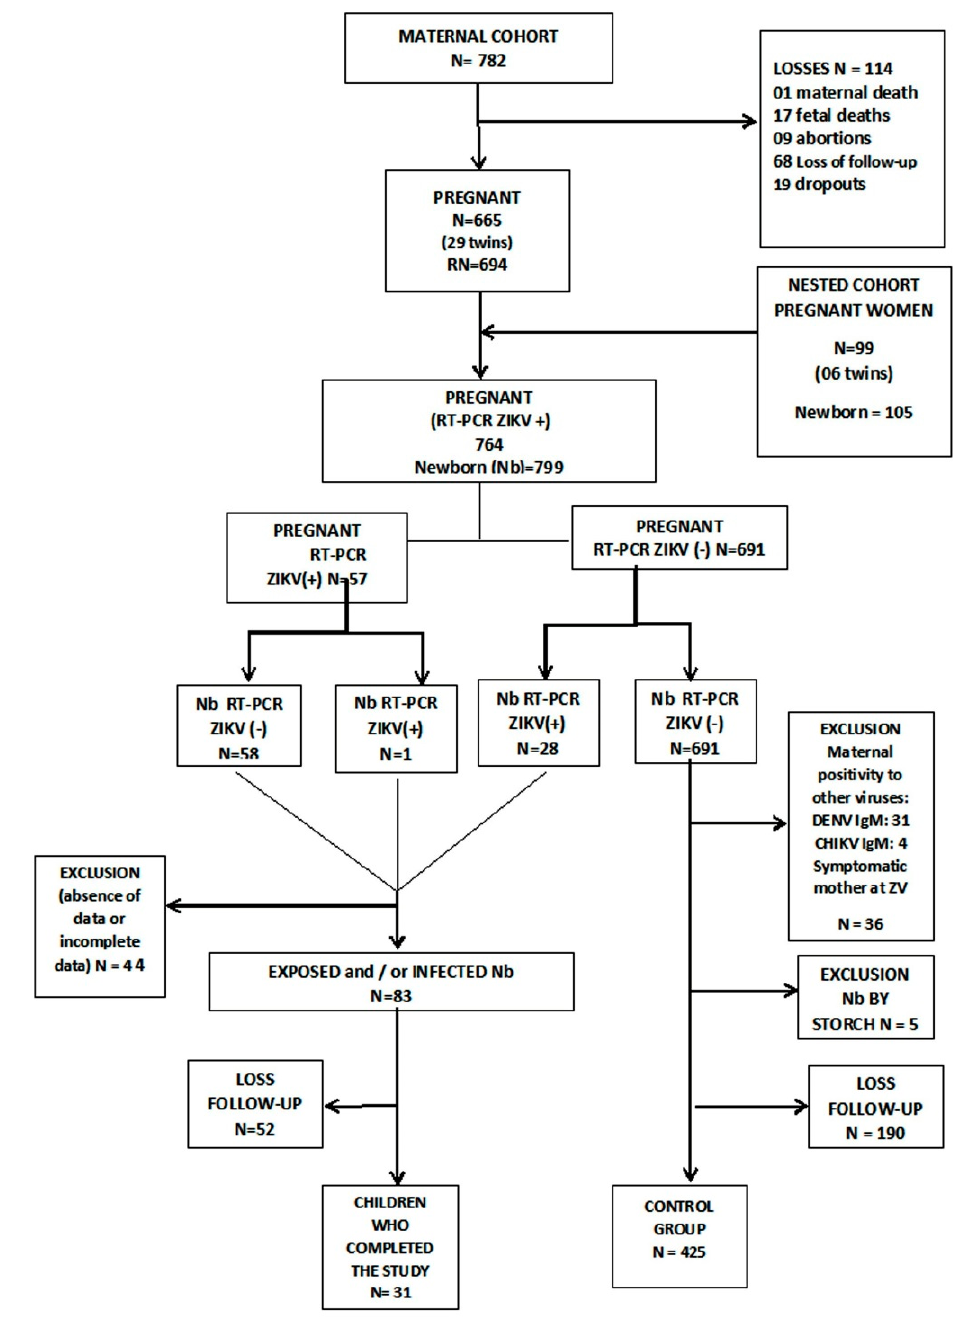
Figure 1. Cohorts’ composition, children groups, and losses of the study.